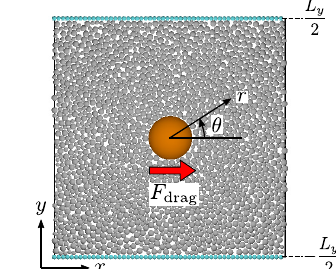
Figure 1. Setup of our simulation. The object is set at the origin when we start the simulation. The wall particles are aligned at y = ± L y / 2. The arrow indicates the direction of the drag. For later discussion, we also introduce the polar coordinates ( r , θ ), whose origin is set at the center of the